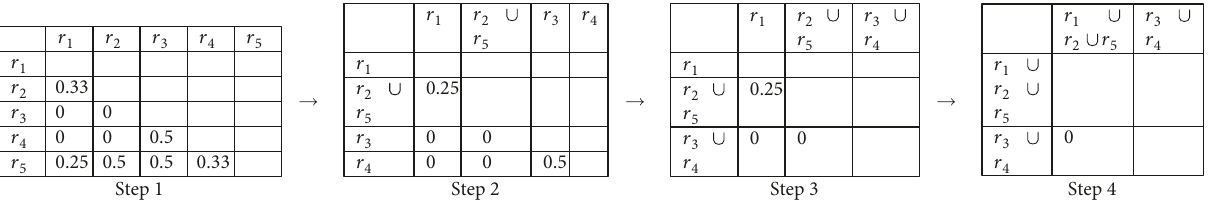
Figure 2: The course of the AHC clustering algorithm for a given knowledge